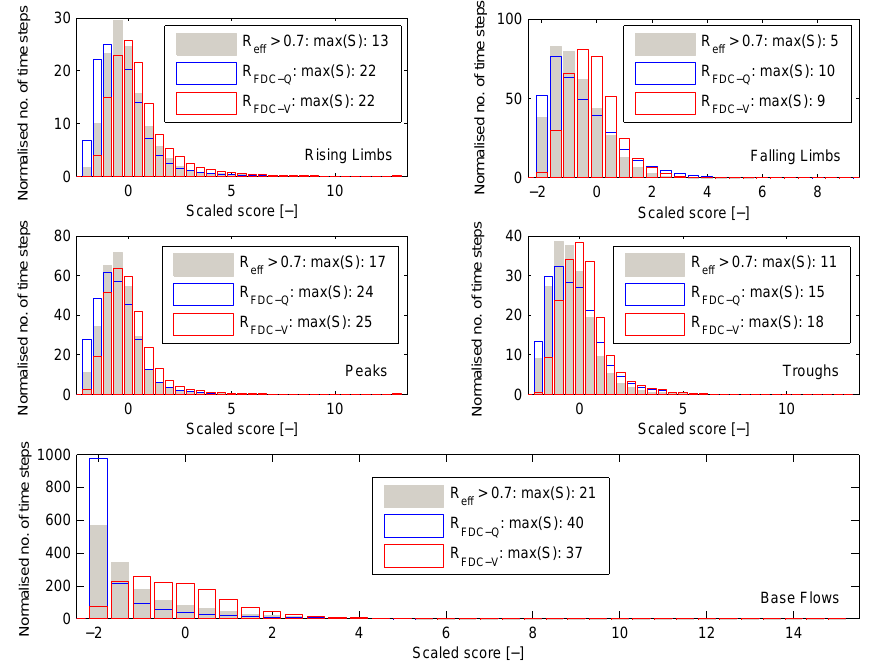
Fig. 13. Scaled scores to limits of acceptability for different parts of the hydrograph at Paso La Ceiba for prediction in 1989–1997 with behavioural parameter-value sets for 1980–1988 for WASMOD. For each performance measure the histograms were normalised by the number of behavioural simulations, which means that the y-axis represents the number of time steps. The upper range of the histogram x- axis was limited to improve the visibility of the lower range, the maximum scaled scores, max( S ), for each criterion are given in the legends and all scaled scores larger or equal to the last bin are plotted in the last bin.